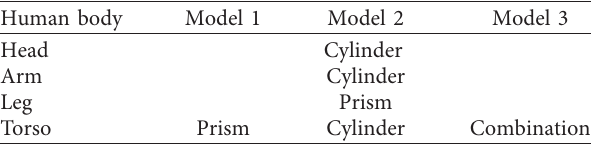
Table 4: Human body models with various torso